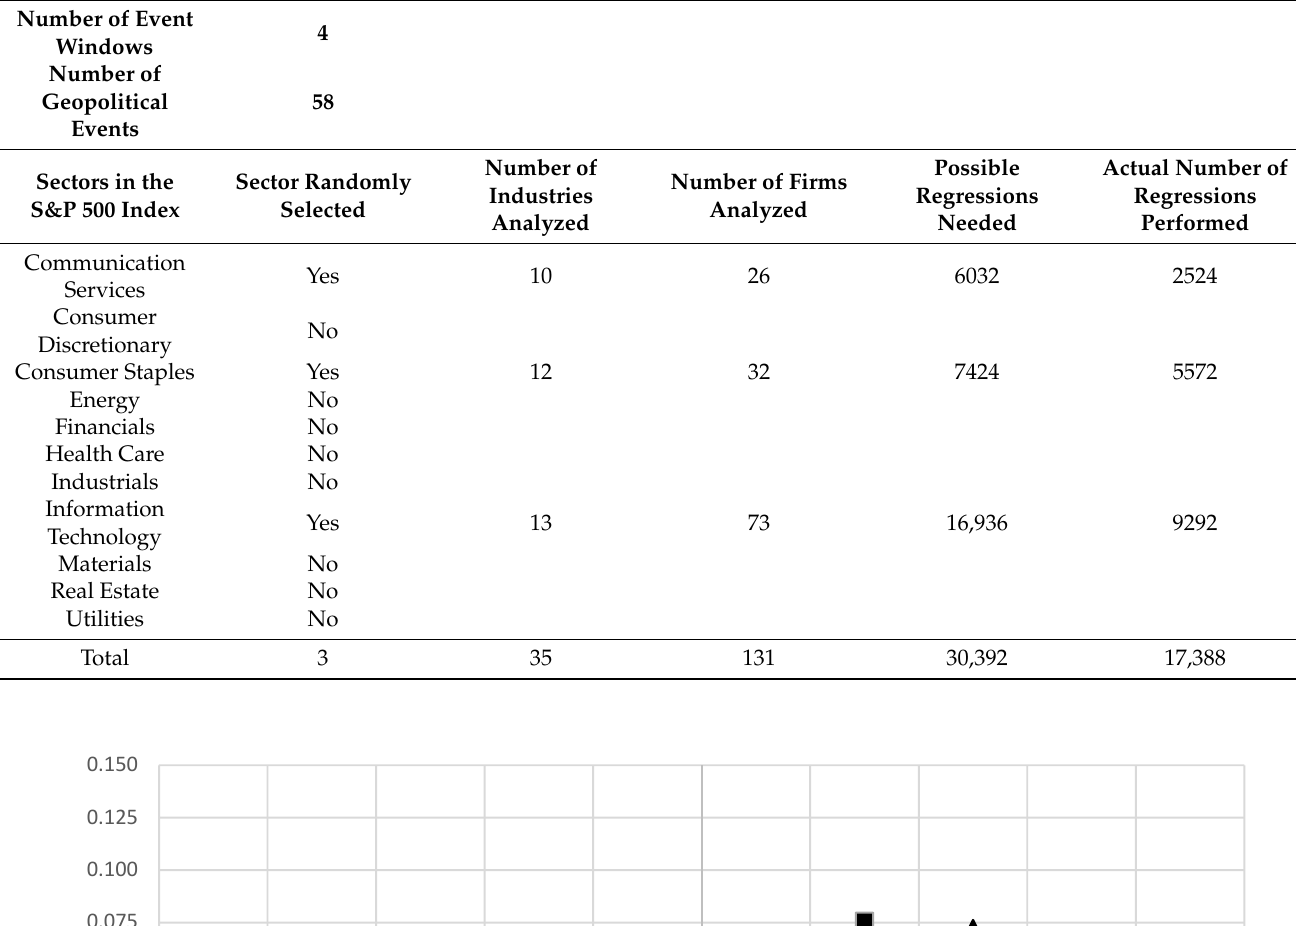
Table A6. Summary of event study regressions needed vs. possible regressions for the Information Technology, Communi- cation Services, and Consumer Staples sectors of the S&P 500 index.